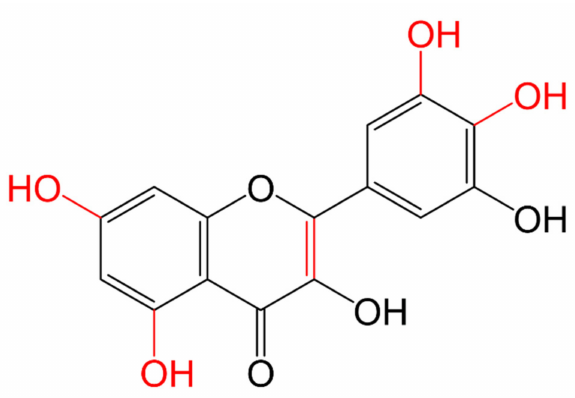
Figure 6. Structural requirements (marked in red) for xanthine oxidases inhibition. Flavonoids can inhibit lipoxygenases if they fulfill structural specifications such as a double bond between C2 and C3, a carbonyl group in C4, and a catechol group in the B ring (OH in C4 (cid:48) is fundamental, in combination with OH in C3 (cid:48) or C5 (cid:48) ). An excess of OH groups lowers the lipophilic affinity of flavonoids (Figure 7)